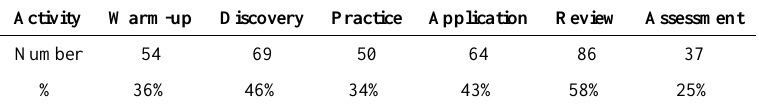
Table 6. Activities teachers used idioms and proverbs in the classroom